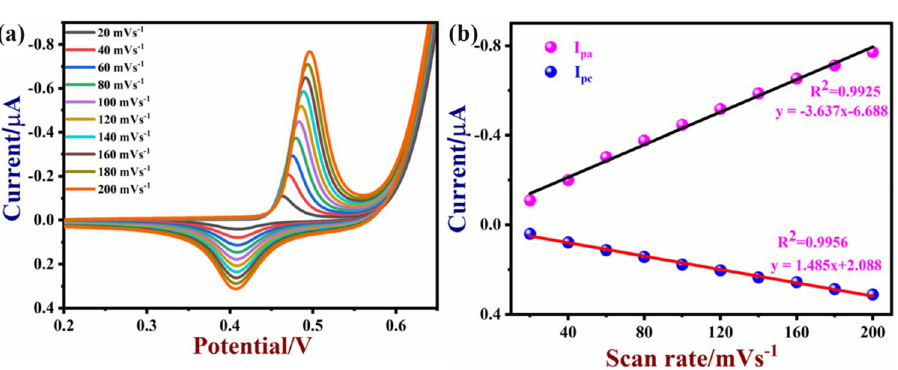
Figure 8. CVs recorded using ( a ) NiO/MoSe 2 /GCE in 0.1 M NaOH containing 50 µM glucose at various scan rates (from 20 to 200 mVs −1 ). ( b ) The linear relationship between the scan rate versus peak currents with a correlation coefficient values of (I pa, R 2 = 0.9925 and I pc, R 2 =